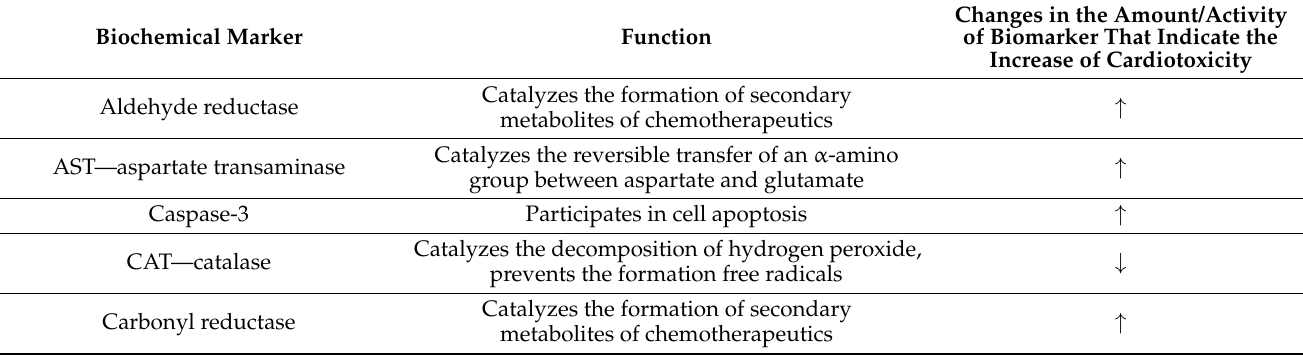
Changes in the Amount/Activity of Biomarker That Indicate the Increase of Cardiotoxicity ↑ ↑ ↑ ↓